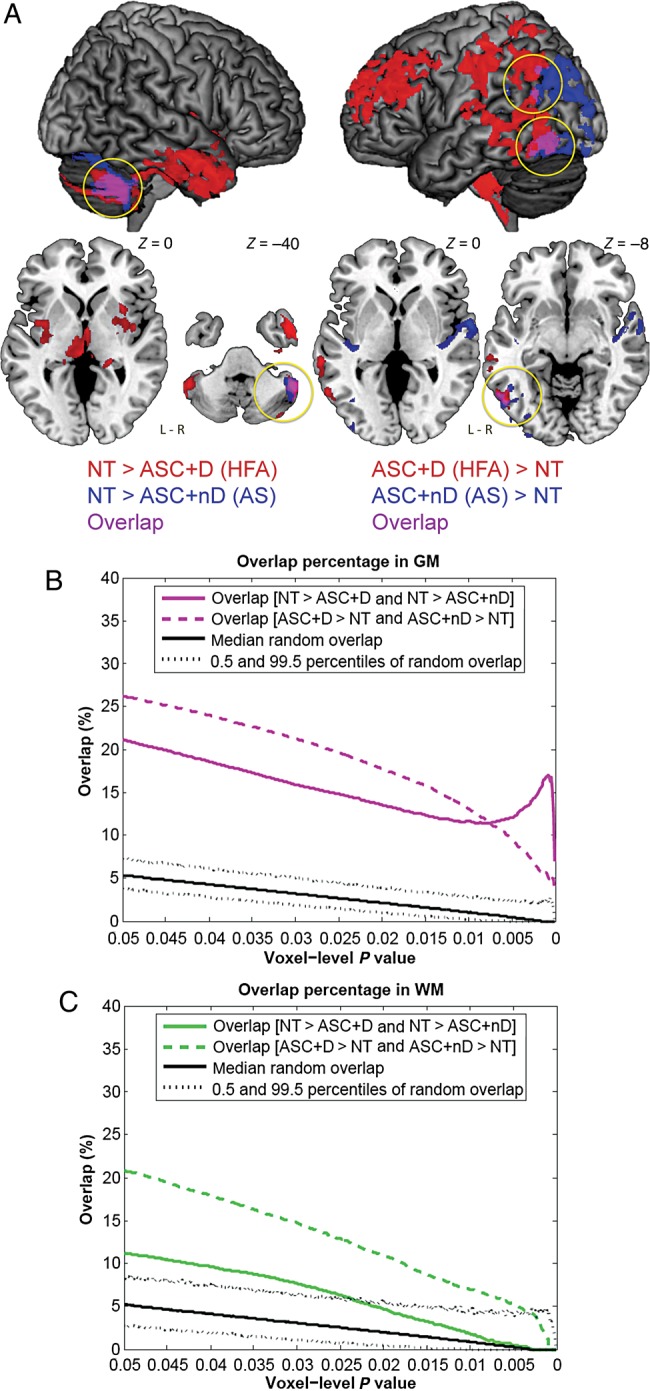
Commonality in neuroanatomy between ASC with versus without language delay when, respectively, contrasted to a neurotypical group. (A) On a selected threshold (voxel-level P < 0.025, cluster-level topological FDR q < 0.05), GM VBM group-difference maps of neurotypical (NT) versus ASC with language delay (ASC+D) and that of NT versus ASC without language delay (ASC+nD) overlapped (purple, also marked by yellow circles) at right cerebellum, left temporo-parietal junction and inferior posterior temporal region. (B) Across voxel-level thresholds, in GM NT–ASC+D and NT–ASC+nD group differences consistently showed nonrandom (i.e., larger than random condition) spatial overlap, indicating statistically significant commonality. Disparity between the two, however, was also present. Black solid line indicates the median overlap occurred under random condition derived from 5000 Monte Carlo simulations, with dotted lines indicating the 0.5 and 99.5 percentiles of the null distribution. (C) Across voxel-level thresholds, in WM NT–ASC+D and NT–ASC+nD group differences showed nonrandom spatial overlap but only in the less stringent thresholds.